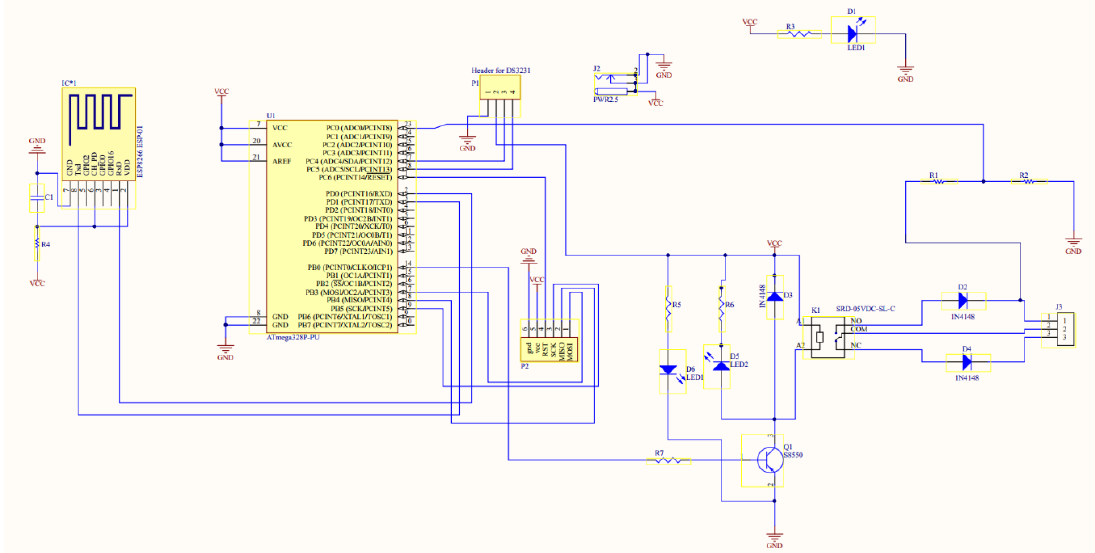
Figure 10. Circuit diagram for the control device.